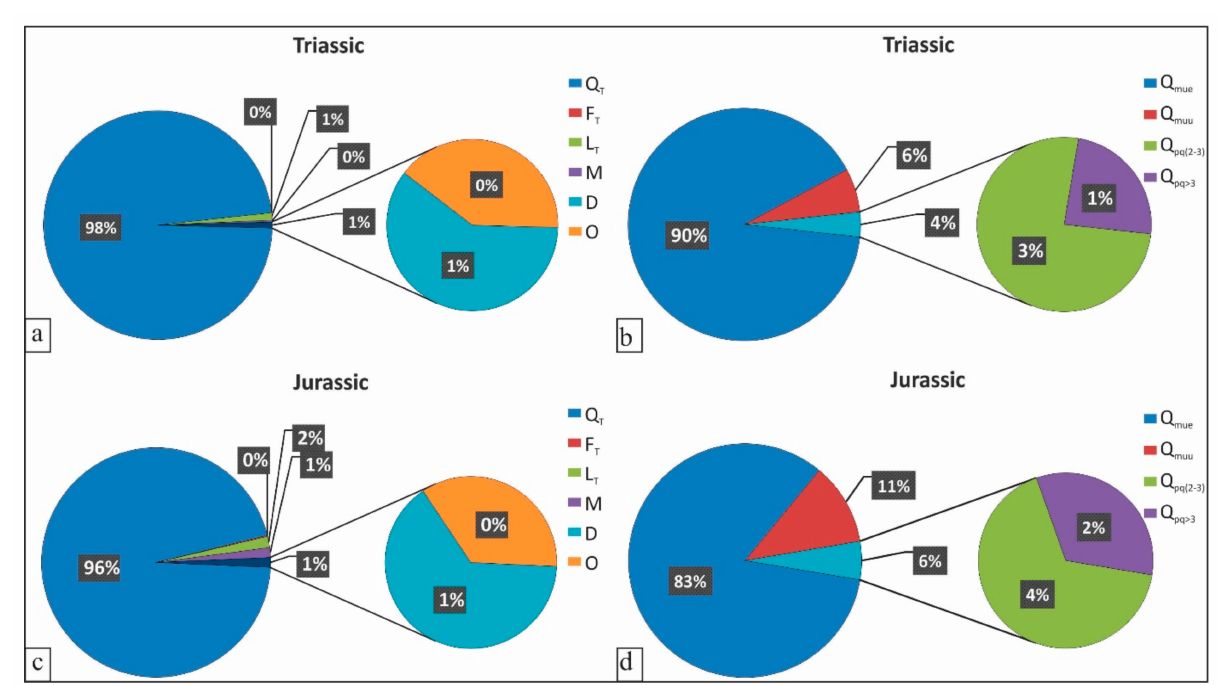
Figure 7. Framework mineralogical composition plots for the siliciclastics of the Kingriali and Datta formations. ( a , b ) Pie charts of the point count analysis showing quartz as the dominant framework composition in the Triassic strata; ( c , d ) pie charts of point count analysis showing quartz as the dominant constituent in the Jurassic strata and monocrystalline quartz has more undulose